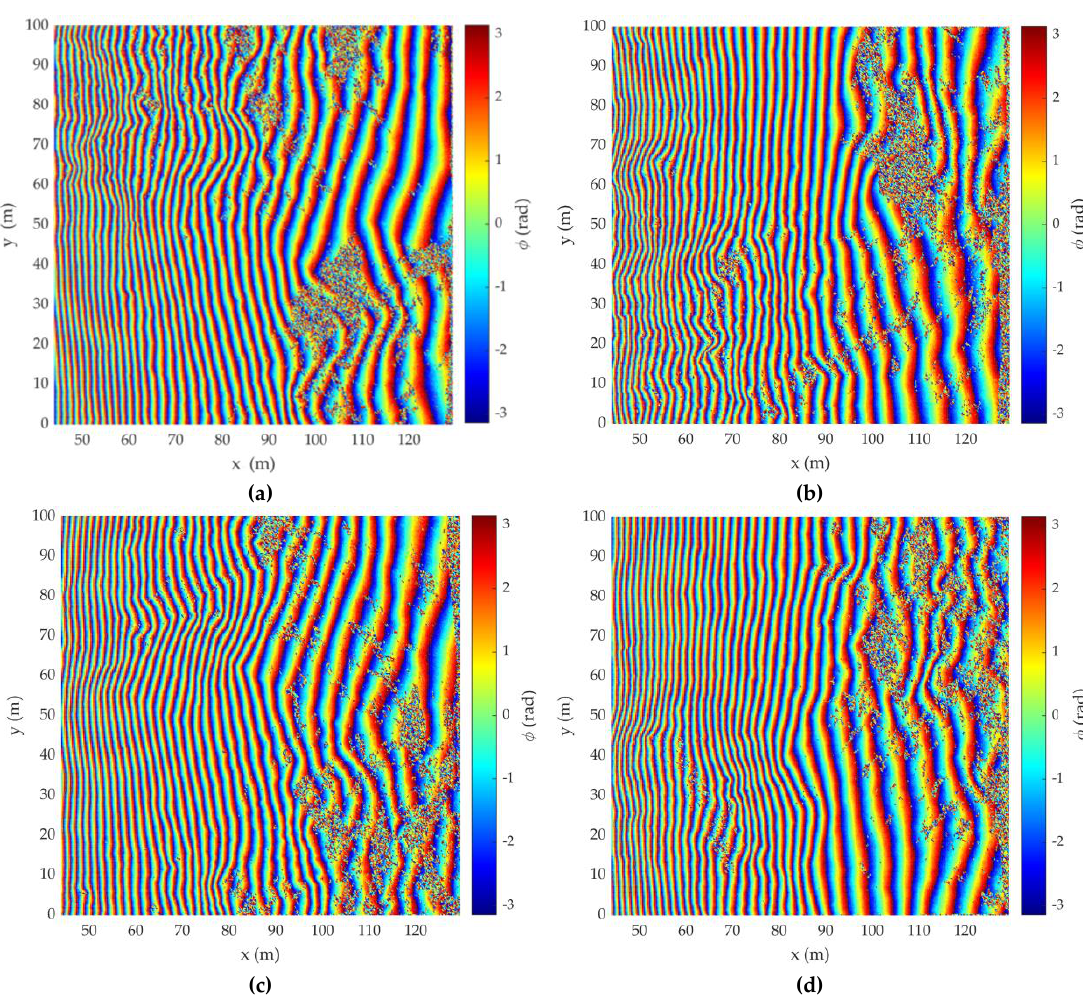
Figure 4. Interferometric phase difference (IPD) of DEM of (a) acquisition 1; (b) acquisition 2; (c) acquisition 3; (d) acquisition 4.